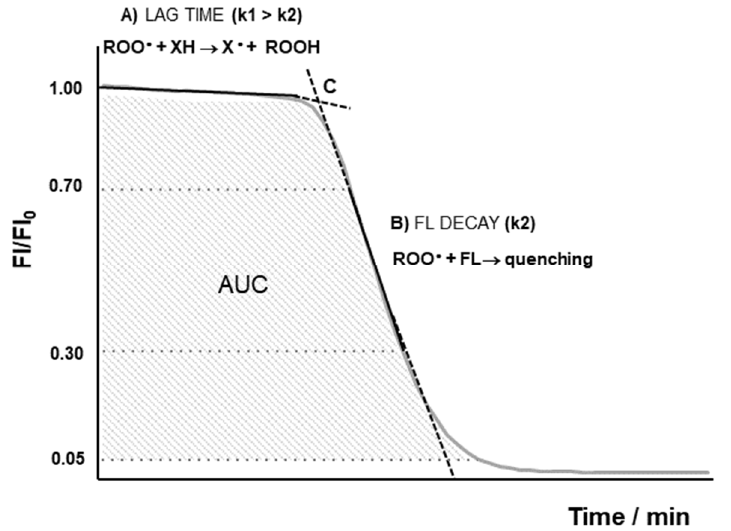
Figure 1. Schematic representation of relative fluorescence vs. time in ORAC assay. Segment A corresponds to reaction between fast reacting antioxidants and AAPH-derived radicals. Segment B (and adjacent zones) corresponds to fluorescein (FL) consumption by AAPH-derived radicals. Point C corresponds to the intersection of lines based on segments A and B.